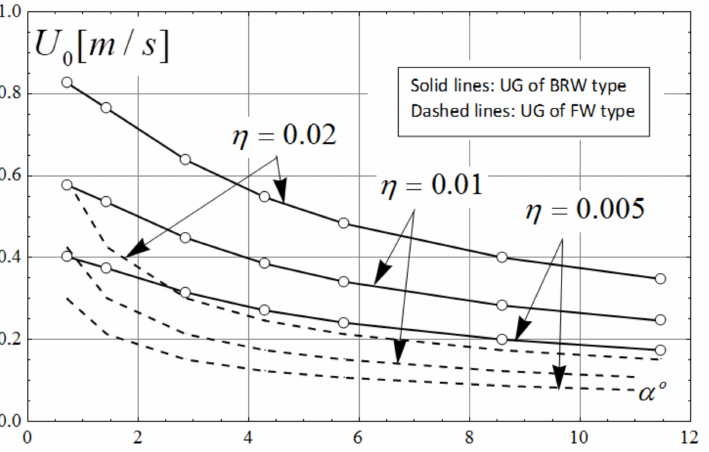
Figure 6. Speed on the trajectory versus angle of attack for different magnitudes of relative differential buoyancy (solid lines—BRW type, dashed lines–FW type).